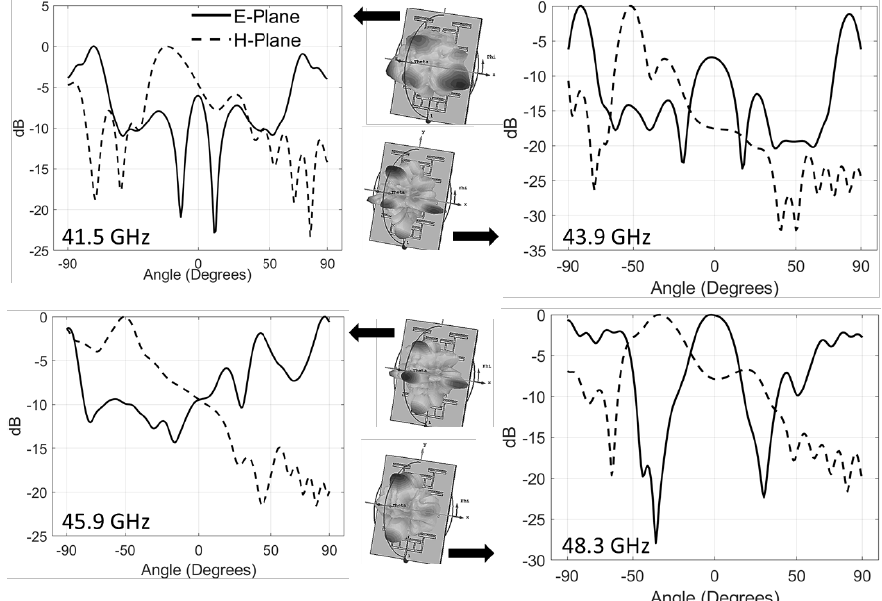
Figure 4. Simulated radiation pattern of the proposed array antenna.